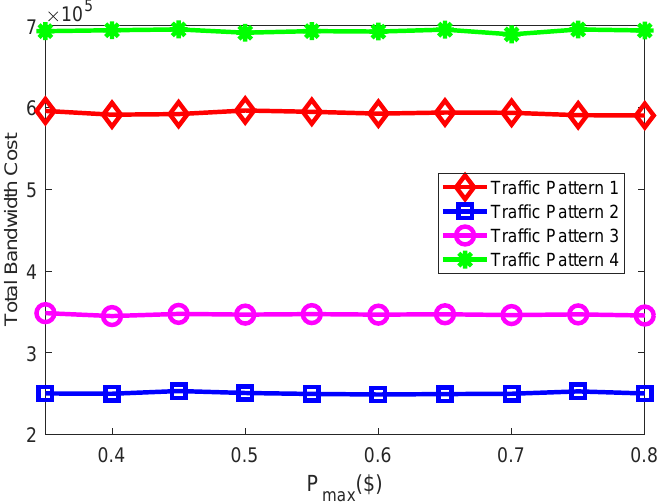
Figure 17. Impact of P max on total bandwidth cost in